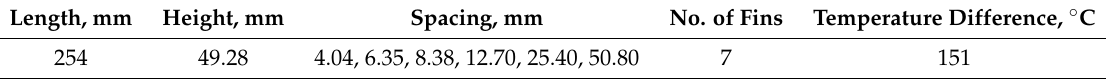
Table 1. Fin design parameters of Jones and Smith [11] used in the simulations. Length,